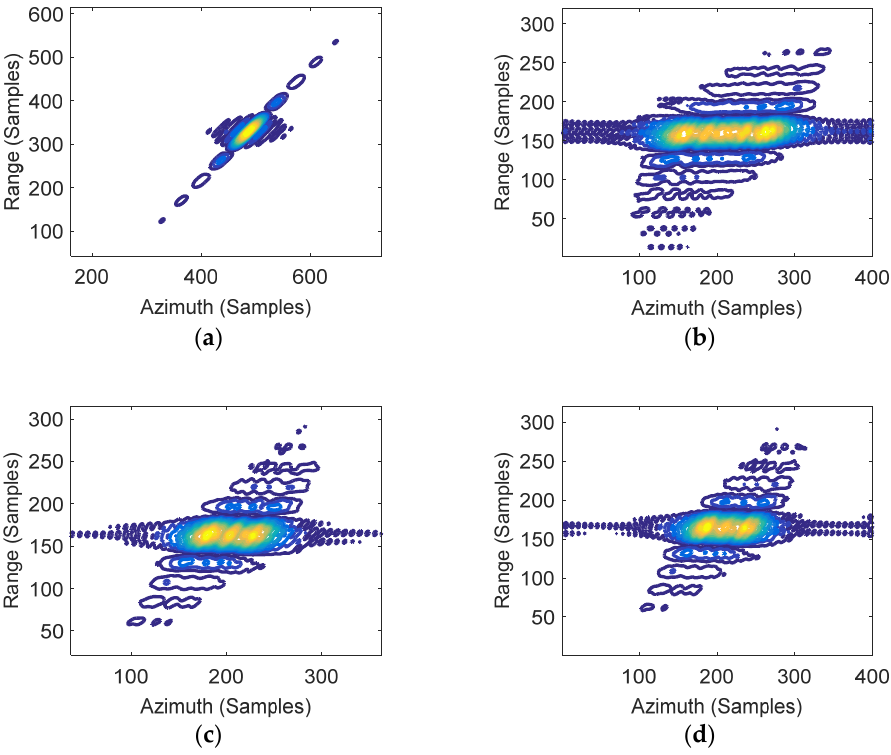
Figure 8. 2-D IRF of targets by CPFA. ( a ) PT0; ( b ) PT1; ( c ) PT2; ( d ) PT3.